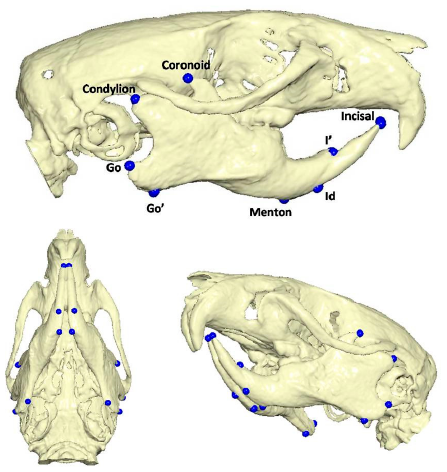
Figure 2. Anatomic landmarks detected in Cone Beam CT reconstructed images.